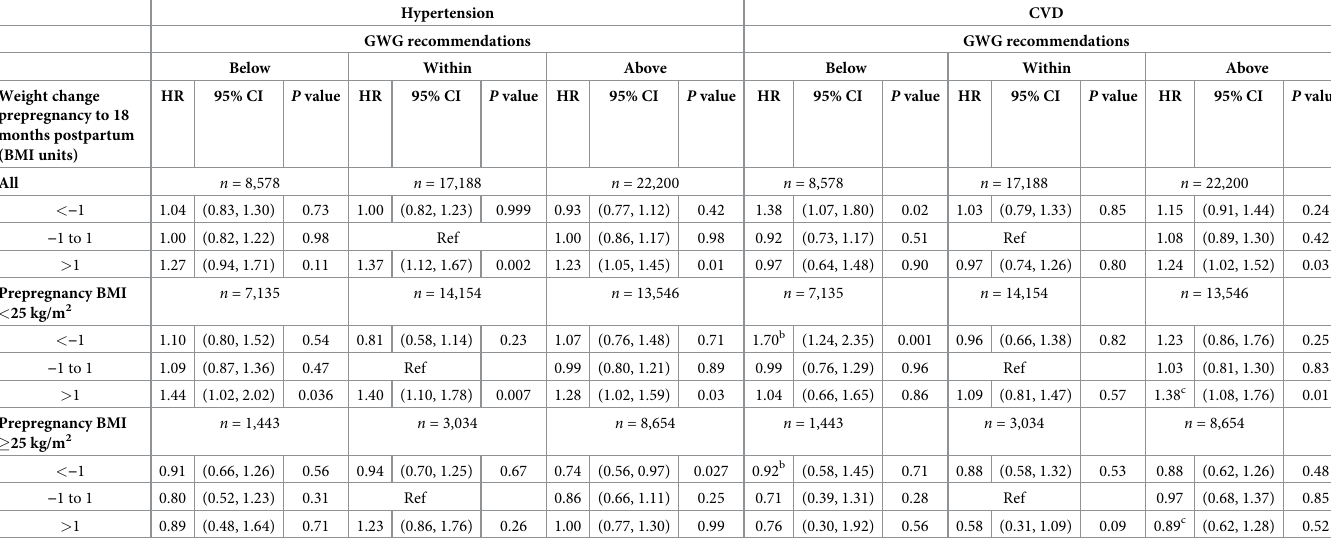
Table 3. Adjusted HRs a (95% CI) of hypertension and CVD according to adherence to the IOM recommendations for GWG and weight change from prepregnancy to 18 months postpartum, n = 47,966. Hypertension